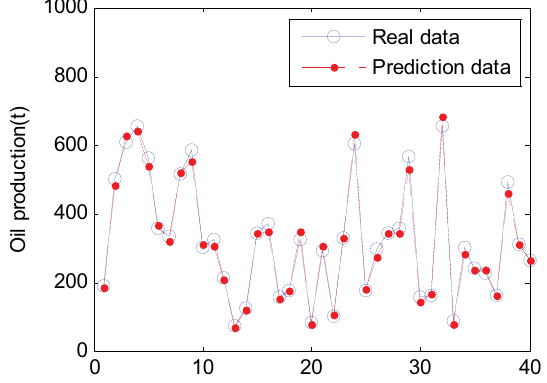
Fig.11. Comparison between real oil production and prediction oil